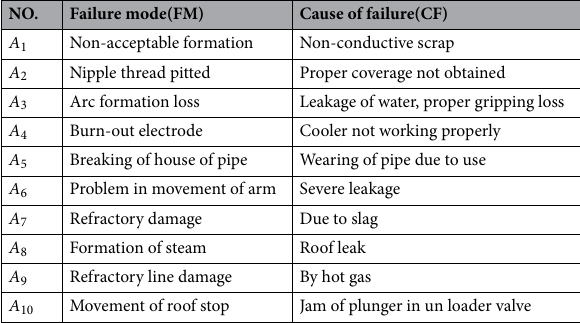
Table 2. The FMEA of the sheet steel production process in Guilan steel